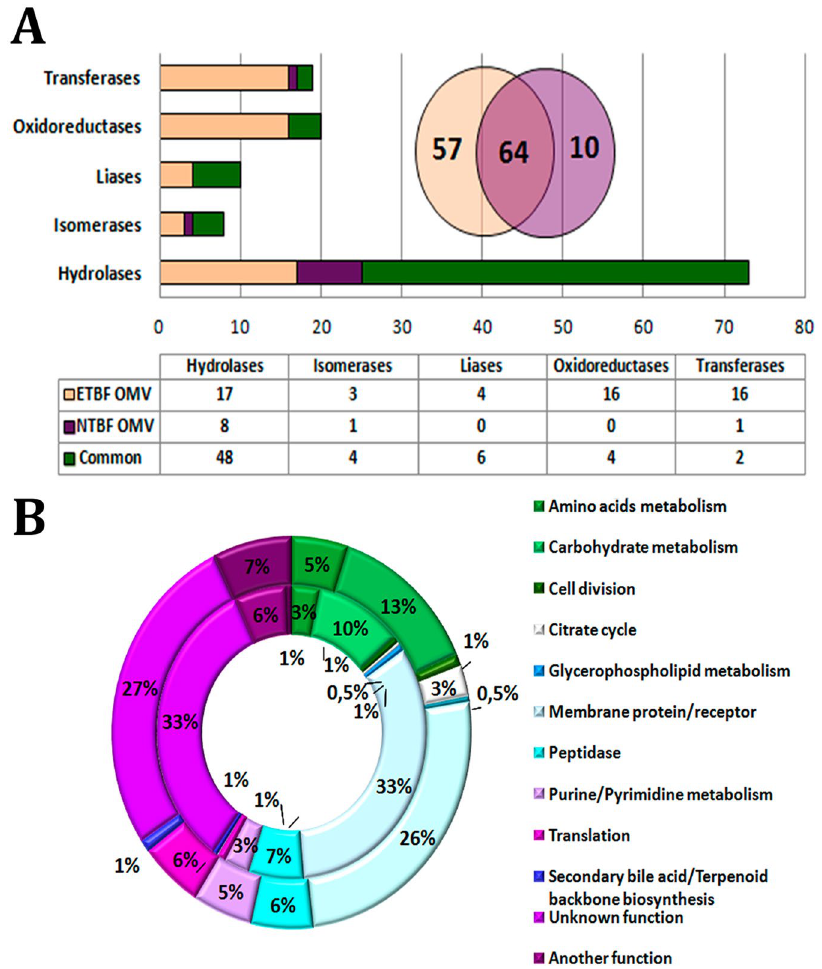
Figure 3. Enzymes identified in both types of vesicles and functional metabolic pathways. ( A ) The columnar histogram represents distribution of enzymes identified in both types of vesicles according to enzyme class. The Venn diagram represents comparative analysis of the total number of enzymes identified in both types of vesicles. ( B ) The main pathways and functional groups of proteins identified in both types of vesicles. External histogram—the proteins identified in ETBF OMVs; internal histogram—the proteins identified in NTBF OMV. The number of identified proteins involved in a particular metabolic pathway is represented as the percentage of the total number of proteins identified in ETBF or NTBF